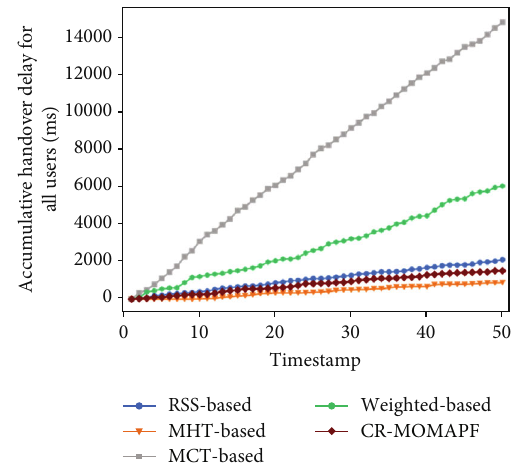
Figure 9: Comparison of accumulative handover delay for fi ve di ff erent handover